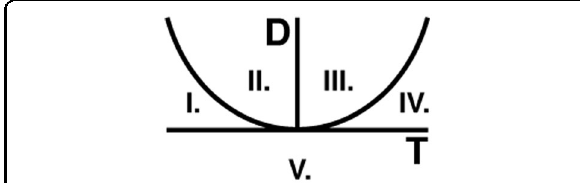
Fig. 6 The Poincaré diagram. The Poincaré diagram, in which we plot the trace T against the determinant D , together with a curve de fi ned by the quadratic: D ¼ 1 T 2 . We, therefore, divide the plane 4 into the fi ve labelled segments, each of which corresponds to a generic equilibrium: (I) Nodal sink; (II) Spiral sink; (III) Spiral source; (IV) Nodal source and (V) Saddle dynamics. Note that only the top-left quadrant (regions I and II) are stable — i.e., it is only in this region that dynamics will return to equilibrium following